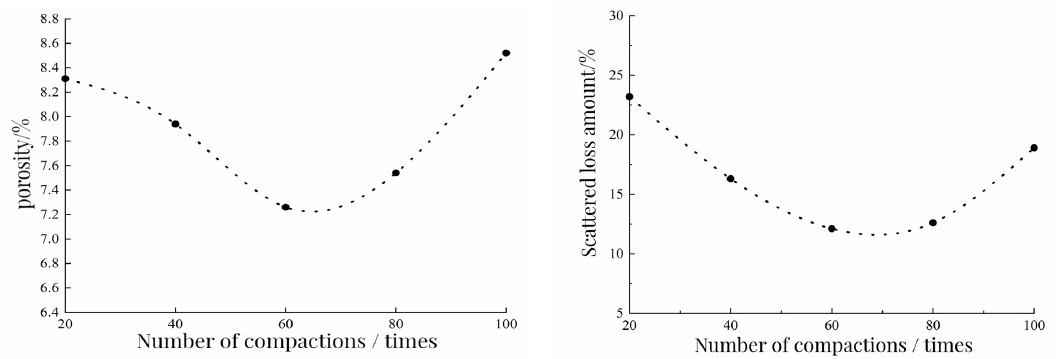
Figure 6. The relationship between porosity and sca tt ered loss and compaction times.